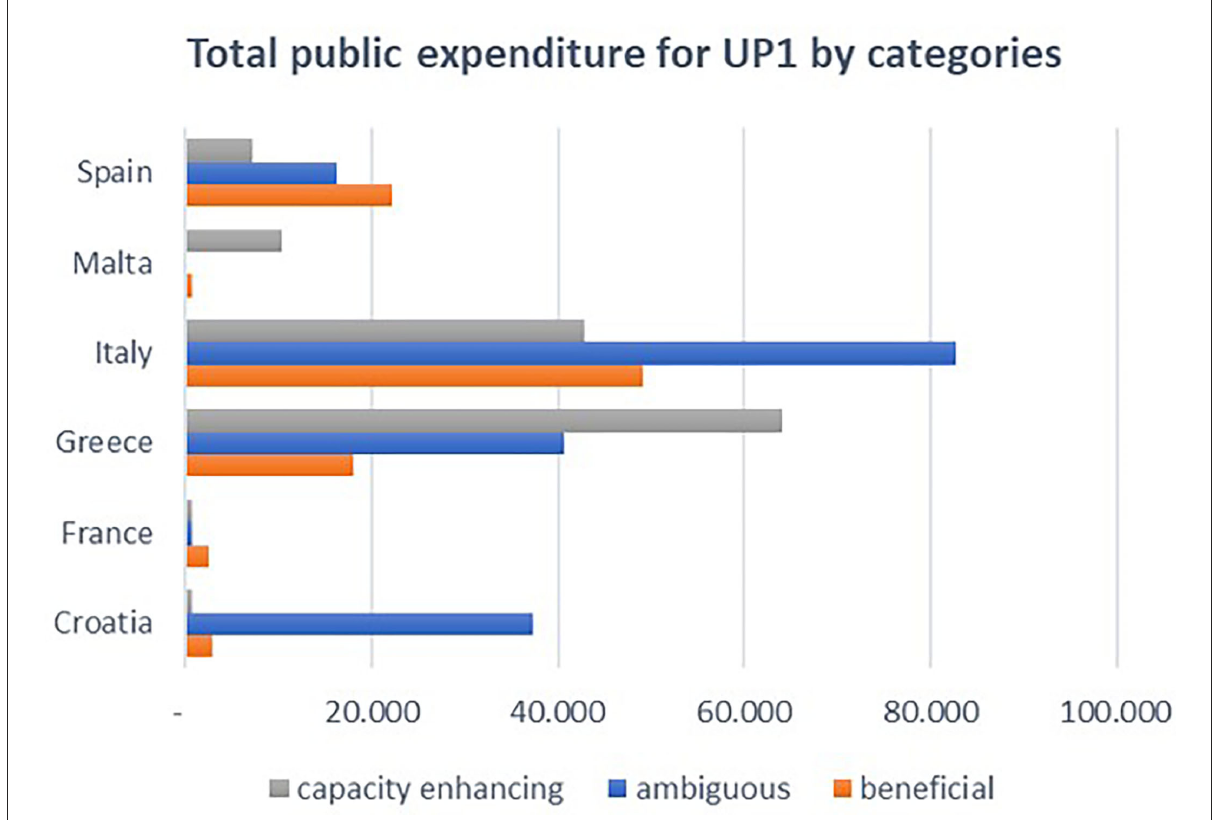
FIGURE12 Total public expenditures of UP1 measures by category and MSs. Elaboration on data from the EMFF List of